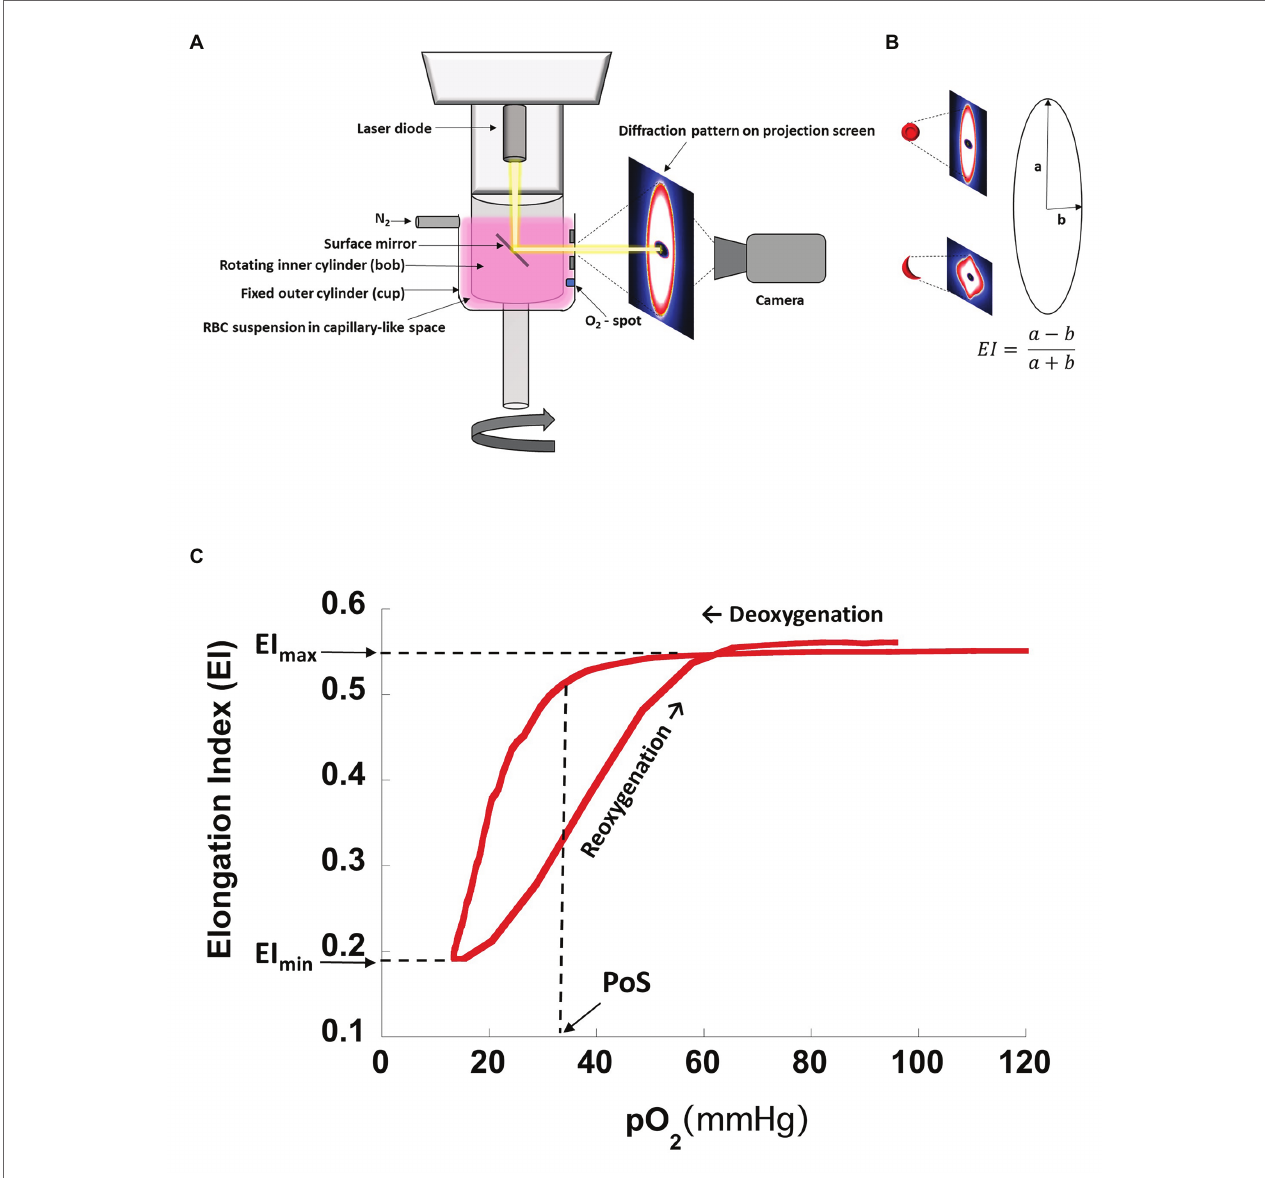
FIGURE 1 | Schematic drawing of oxygenscan setup with representative curve. (A) Schematic drawing of oxygenscan. (B) Representative diffraction pattern of RBCs in suspension. With deoxygenation and shear stress (30 Pa) in the capillary-like space between the cup and bob, RBCs containing HbS tend to deform to sickled shapes causing the diffraction pattern to change from an elliptical to a rhomboid pattern. Elongation index (EI) is calculated as a ratio of radii along the long and short axis of the diffraction pattern. (C) Representative oxygenscan curve of HbS RBCs. Maximum elongation index, EI max , is the EI measured at full oxygenation (pO 2 100–150 mmHg) and represents baseline RBC deformability in arterial circulation. Minimum elongation index, EI min , is the EI measured at the lowest oxygen saturation (pO 2 < 20 mmHg) and represents RBC deformability in post capillary venules. Point of sickling, PoS, is the pO 2 at which the EI decreases to 95% of EI max during deoxygenation and represents a patient/disease-status-specific pO 2 at which HbS polymerization is accelerated and drives the sickling of RBCs that